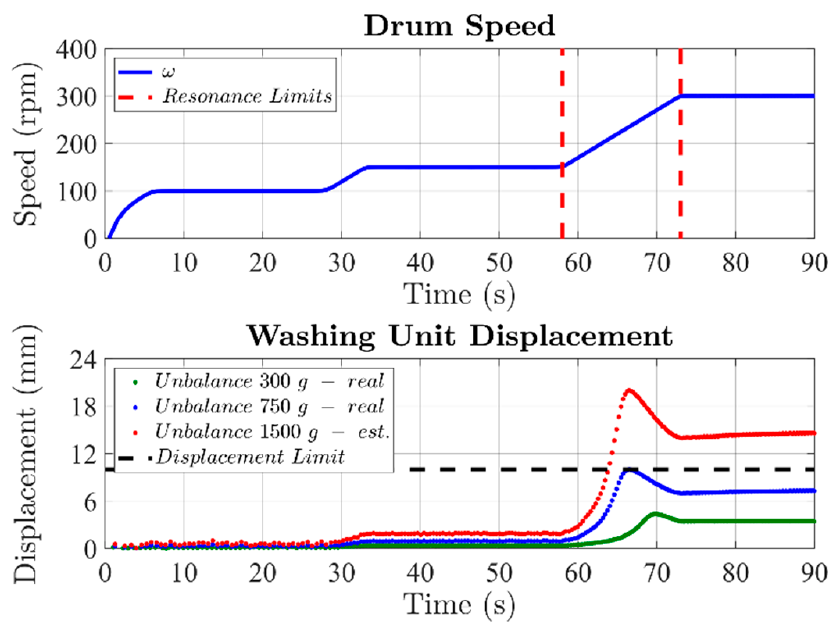
Figure 3. Displacement of the washing unit for different values of the laundry unbalance. Nevertheless, the laundry unbalance can also be larger than 750 g, e.g., if a few items with huge soaking properties are washed. Such properties are typical for the shower towels that can soak up a water mass with about five times their dry weight. Therefore, in a real scenario, an unbalanced mass close to 1500 g cannot be excluded. For such cases, the washing unit’s predicted displacement reaches 20 mm (see Figure 3, red